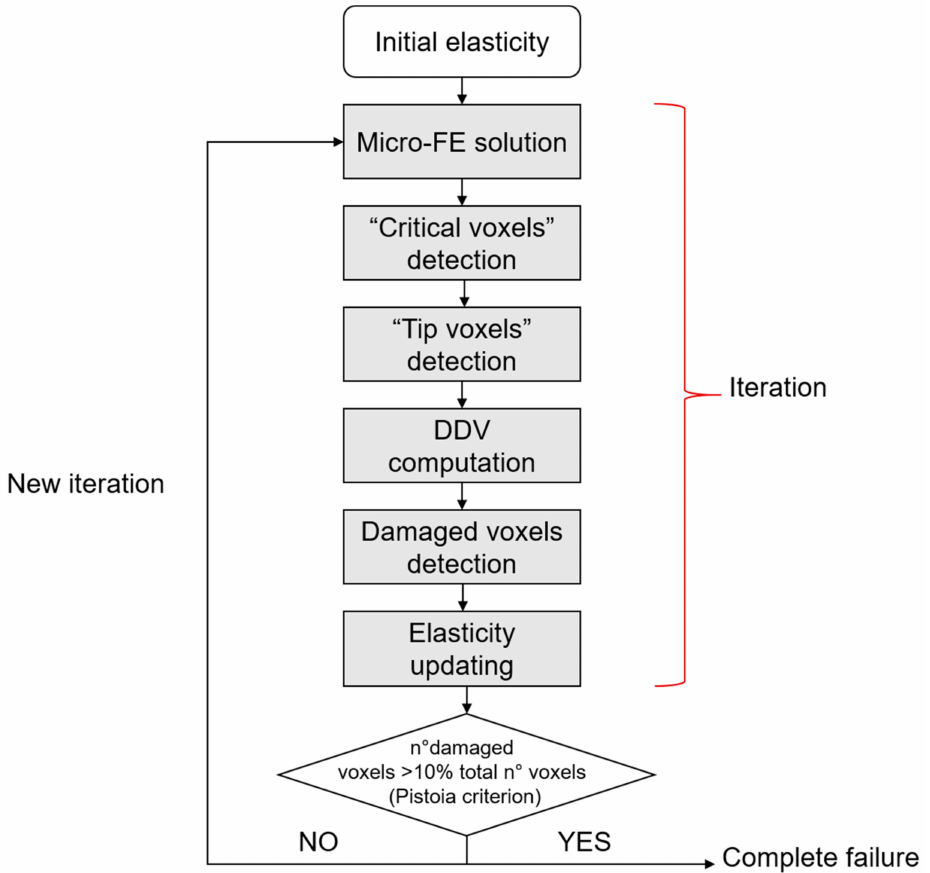
Figure 11. Stress gradient algorithm. “Critical voxels” are the voxels that exceed a defined stress threshold. “Tip voxels” are the center of the spherical sensation region of the osteocytes and are eligible sites for damage propagation. In the stress gradient algorithm, a key role is played by the deletion direction vector (DDV), that indicates a direction for crack propagation. The iteration stops when the total failure of the sample is reached, according to the Pistoia criterion [109].